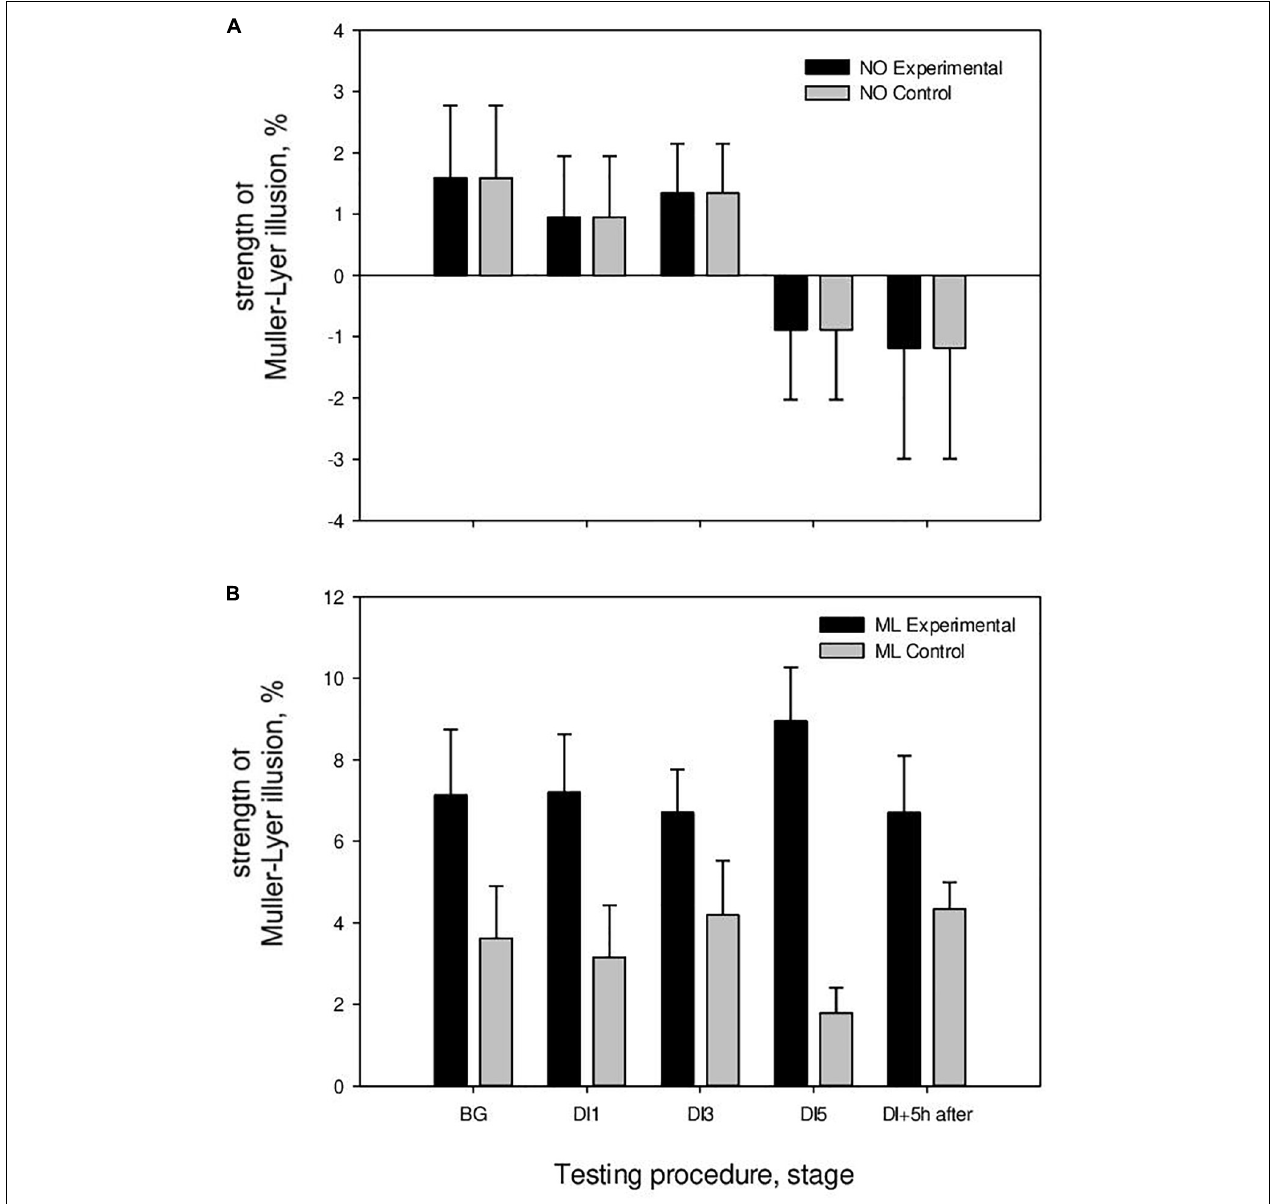
FIGURE 4 | The strength of the Müller-Lyer illusion in the DI with HFEMS and without HFEMS. (A) The results of the perception of neutral segments. (B) Results of perception of segments with arrows (Müller-Lyer illusion). All data are presented as mean ± standard error.